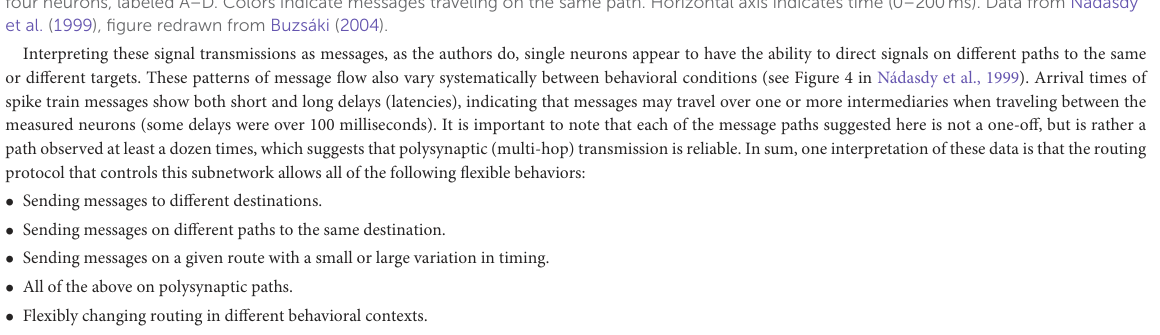
FIGURE2 Exchange of spike train messages among four neurons over time in the rat hippocampus during wheel running. Messages are seen to pass among four neurons, labeled A–D. Colors indicate messages traveling on the same path. Horizontal axis indicates time (0–200ms). Data from Nádasdy et al. (1999), figure redrawn from Buzsáki